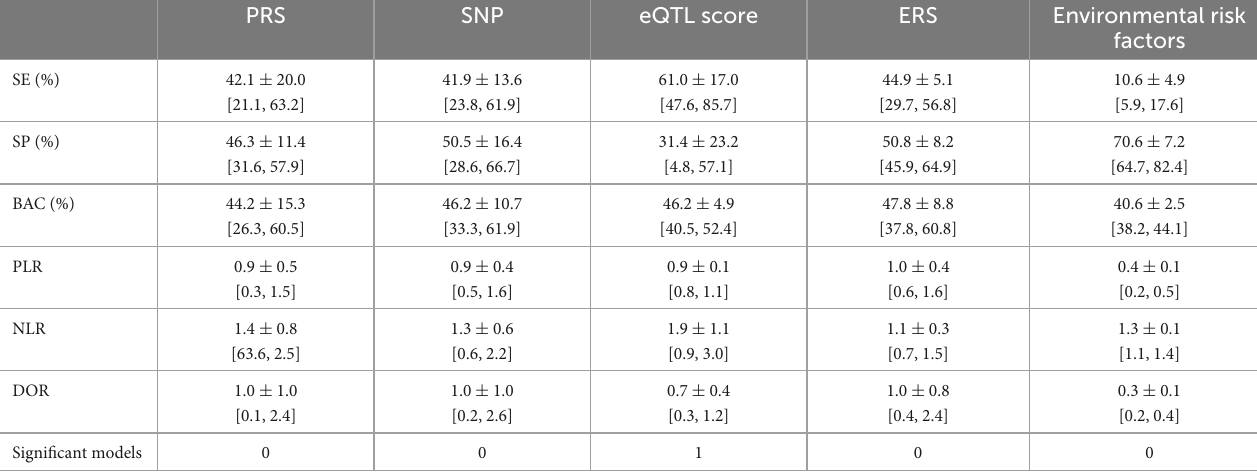
TABLE 6 Performance measures of: (1) a genetic schizophrenia polygenic risk score (PRS), (2) a list of psychosis-associated single nucleotide polymorphisms (SNPs), (3) expression quantitative trait loci (eQTL) scores (43) of a list of psychosis-associated genes expressed in the brain; (4) an